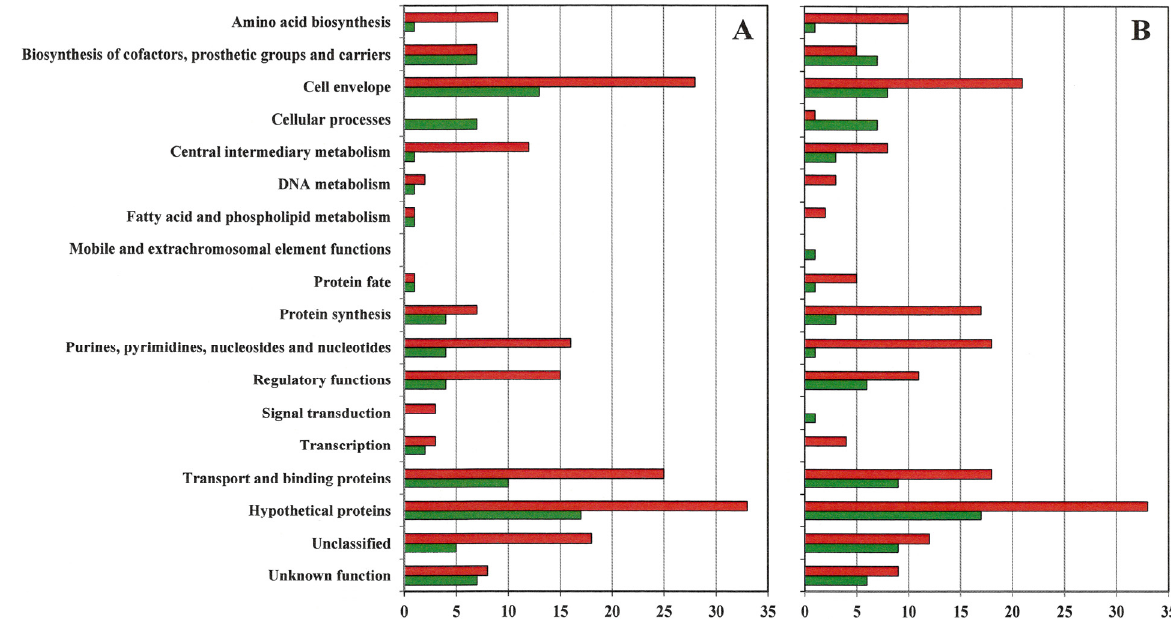
Figure 1. Gene expression patterns. The number of genes by functional group upregulated (green bars) and downregulated (red bars) at least two-fold in VISA 13136p − m + V5 ( A ) and 13136p − m − V20 ( B ) relative to gene expression in vancomycin-susceptible S. aureus (VSSA) parent 13136p − m +